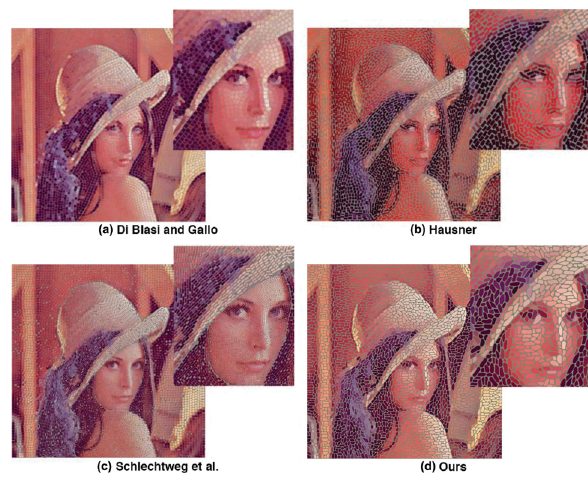
Fig. 16 Comparison with previous tile mosaic algorithms.